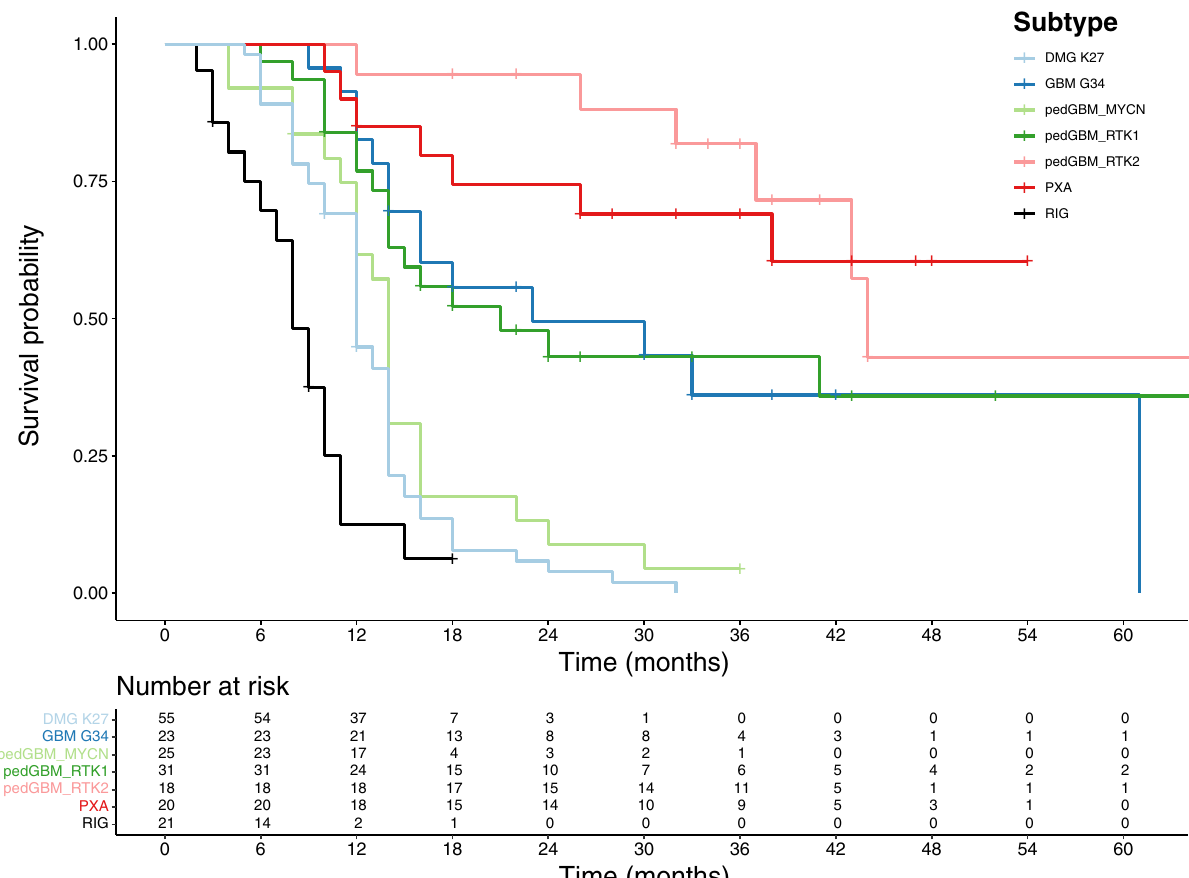
Fig. 2 Kaplan – Meier curves illustrating overall survival for RIGs with representative CNS tumor entities. PXA pleiomorphic xanthoastrocytoma, pedGBM_RTK1 pediatric glioblastoma subclass RTK1, pedGBM_RTK2 pediatric glioblastoma subclass RTK2, pedGBM_MYCN pediatric